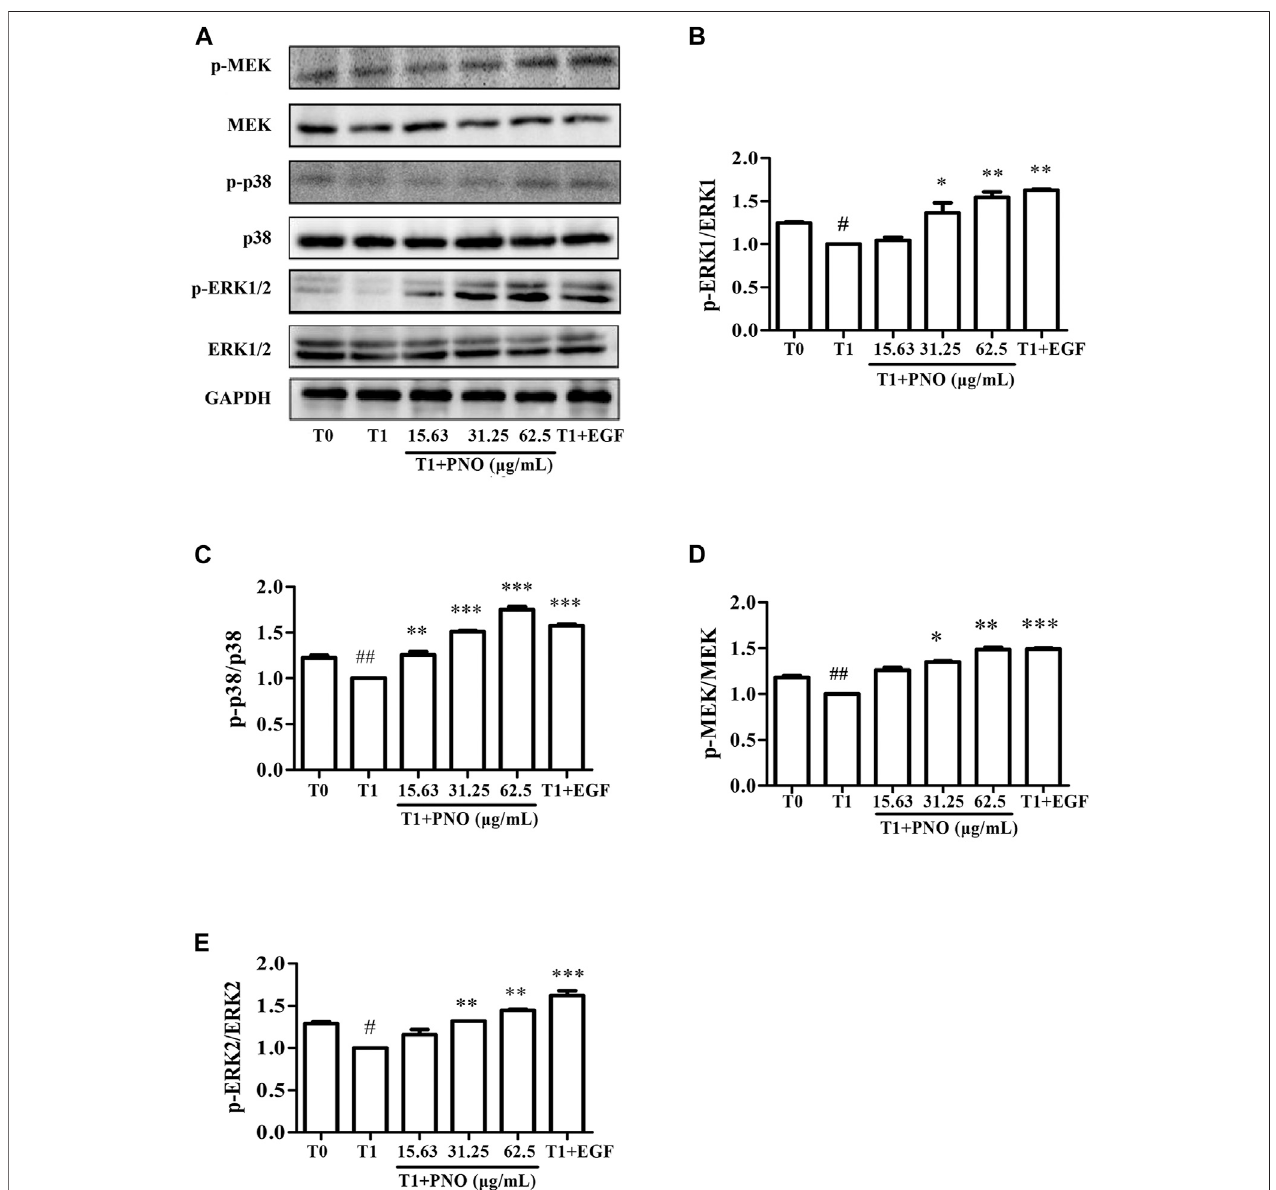
FIGURE6| EffectofPNOonkeyproteinsofMAPKsignalingpathwayinreplicativesenescentNIH-3T3cells. (A) Westernblottinganalysisofexpressionofp-MEK/ MEK,p-p38/p38, p-ERK1/2/ERK1/2. (B – E) Quanti fi cationofbandsrelativetoGAPDHusing ImageJsoftware. Alldataarepresented asthemean ± SDofatleastthree independent experiments. # indicatesasigni fi cantdifferent relative toT0group. # p < 0.05, ## p < 0.01, ### p < 0.001.*Indicates asigni fi cantdifferent relative toT1group. * p < 0.05, ** p < 0.01, *** p <